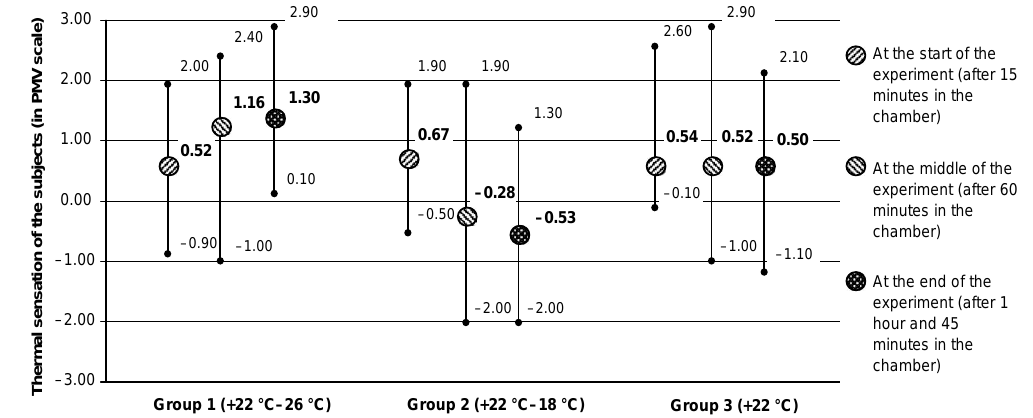
Fig. 3. Results of the evaluation of the thermal sensation in the PMV scale of the